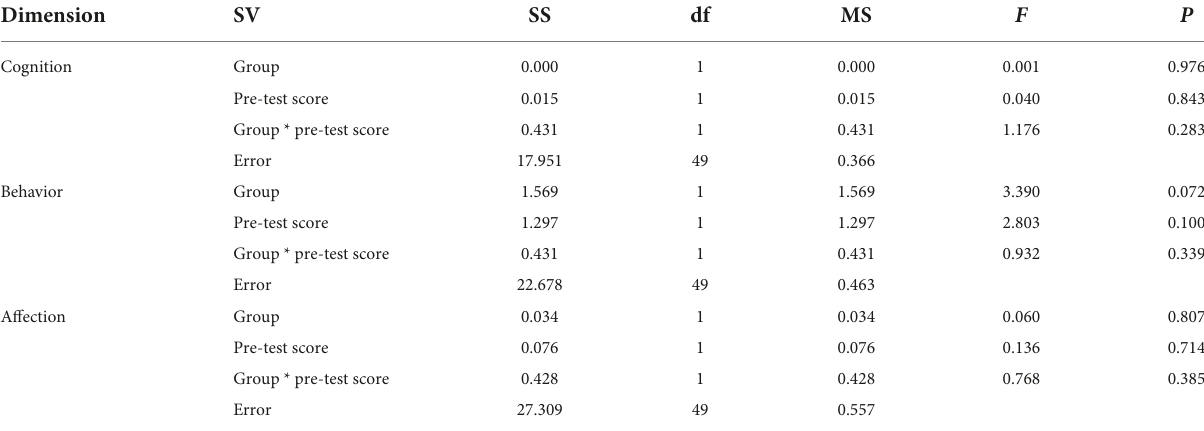
TABLE 11 Homogeneity test of regression coefficients of post-test results of different dimensions of learning attitude. Dimension SV SS df MS F P Cognition Group 0.000 1 0.000 0.001 Pre-test score